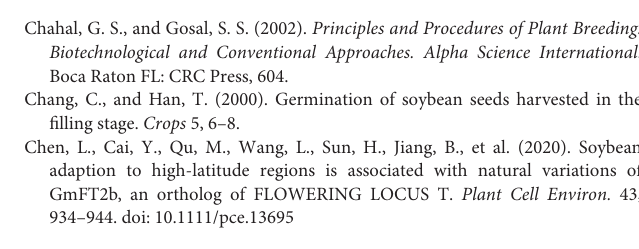
Supplementary Table 1 | The sources and maturity group of parents. Supplementary Table 2 | The primer sequences used in this study. Supplementary Table 3 | The phenotype and haplotype combinations of E1-E4 in hybrid progenies. “NA” means these materials cannot reach R7 until the first frost